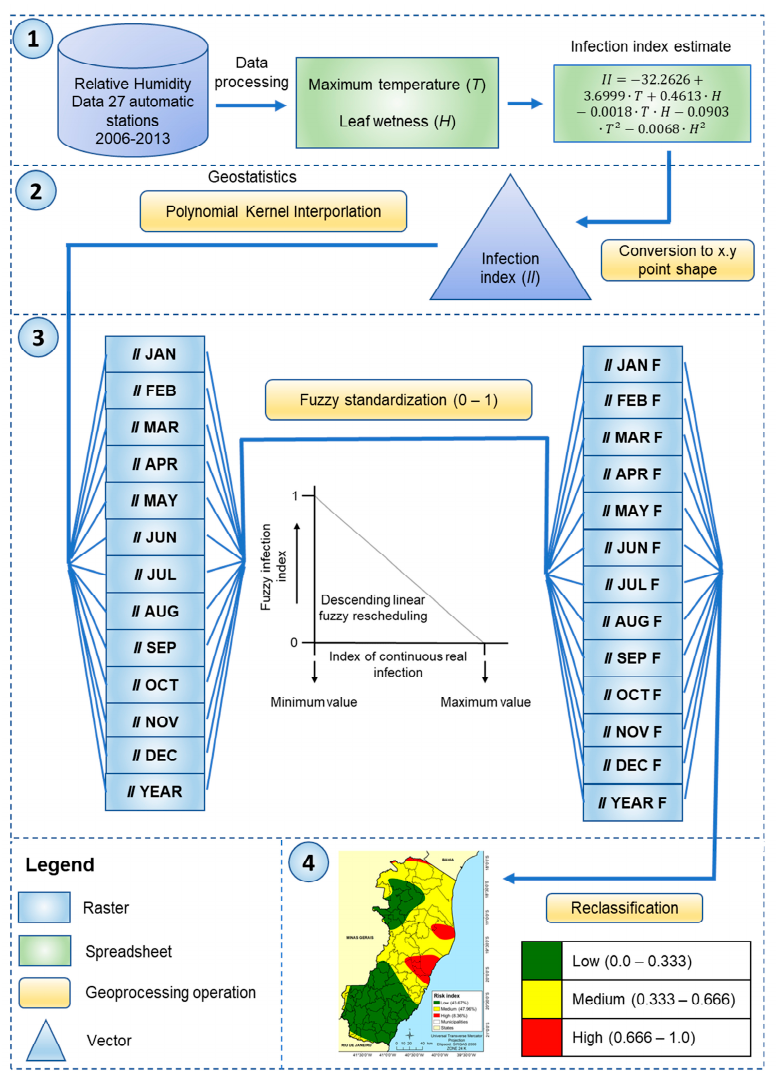
Figure 3. Methodological flowchart containing the four steps necessary to prepare the zoning of the risk index for the occurrence of eucalyptus rust ( Austropuccinia psidii ) based on the fuzzy